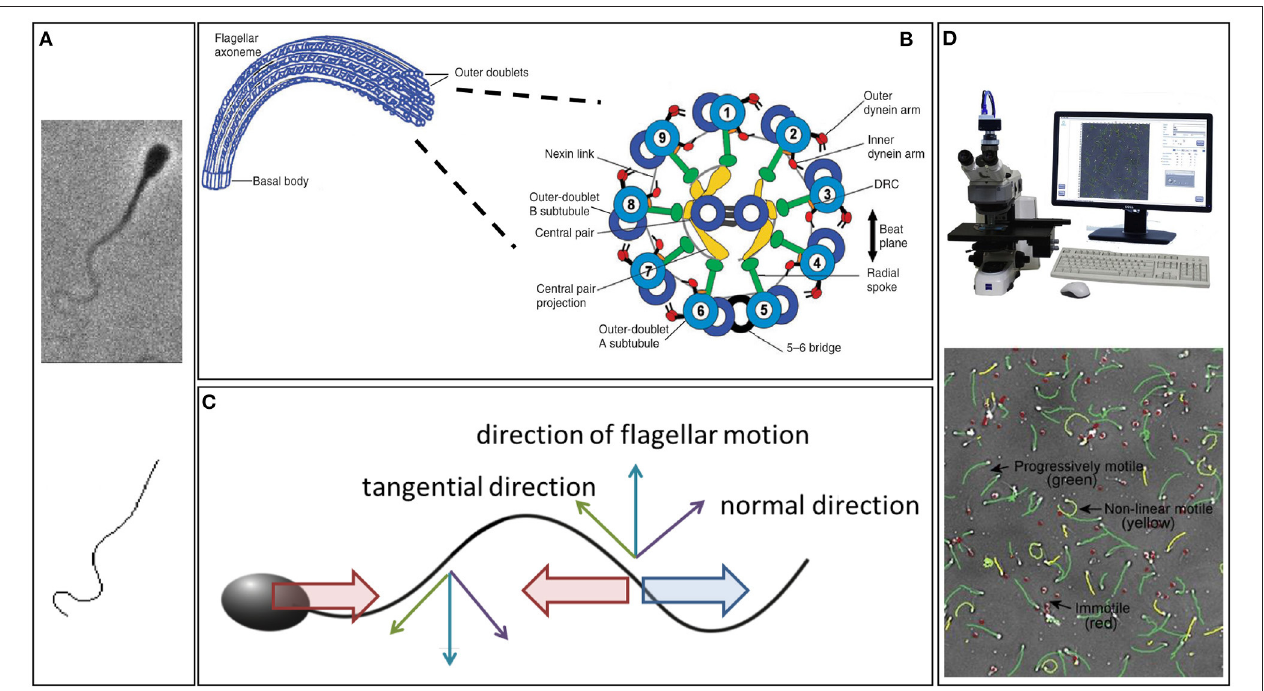
FIGURE 1 | (A) An example of a phase contrast image of a swimming bull sperm (upper), with the digital capture of its flagellum (lower). (B) The internal structure of the flagellum, showing the dynein molecular motors. Their contraction induces a couple that acts to slide the microtubule doublets relative to each other, which, combined with the fact the microtubule doublets are constrained at the flagellum-cell body junction, induces flagellar bending (Summers and Gibbons, 1971; Brokaw, 1972a). (C) Resistive force theory, which simply relates local flagellum velocity, in the tangential and normal directions, to the forces exerted on the surrounding fluid. The thin upward blue arrow is the flagellum velocity, with the tangential and normal components represented by green and purple thin arrows, respectively. Noting that twice as much force per unit length is required to move the flagellum through the fluid perpendicular to itself compared to tangentially, the upwards-moving flagellum thus exerts a net force on the fluid in the horizontal direction to the right (large blue arrow); similarly for the thin downward blue arrow for the downwards flagellum velocity. Hence, an equal and opposite drag force acts leftwards on the flagellum (leftward red arrow). If the sperm was stationary this would violate Newton’s second law, since the inertial term (mass × acceleration) is negligible, entailing that the total force on the cell must be zero. Thus, the sperm must move to the left at a speed that ensures that the additional drag from this motion (rightward red arrow) balances out the leftward force on the flagellum. Analogous reasoning can be used to find the sperm’s vertical and angular velocities in terms of the flagellar beat pattern and, thus, the sperm trajectory can be constructed from knowledge of its beat pattern. (D) An example CASA system and cell tracking. (A) is republished from Walker et al. (2020b) with permission, under the terms of the Creative Commons Attribution License https://creativecommons.org/licenses/by/4.0/. (B) is republished with the permission of The Company of Biologists Ltd from Lindemann and Lesich (2010), permission conveyed through the Copyright Clearance Center, Inc. (D) is reprinted from Amann and Waberski (2014), with permission from Elsevier.